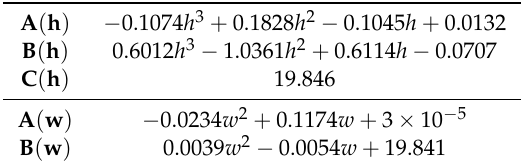
Table A3. Formulas for the coefficients in (8) and (9),